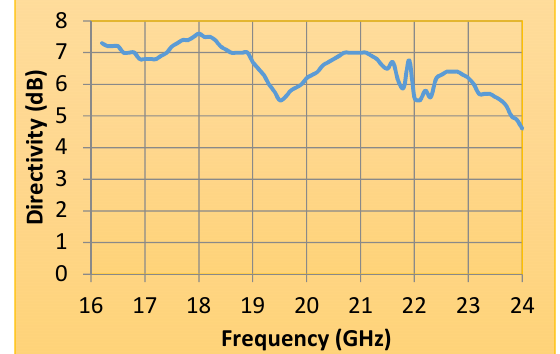
FIG. 9. DIRECTIVITY OF THE SIMULATED